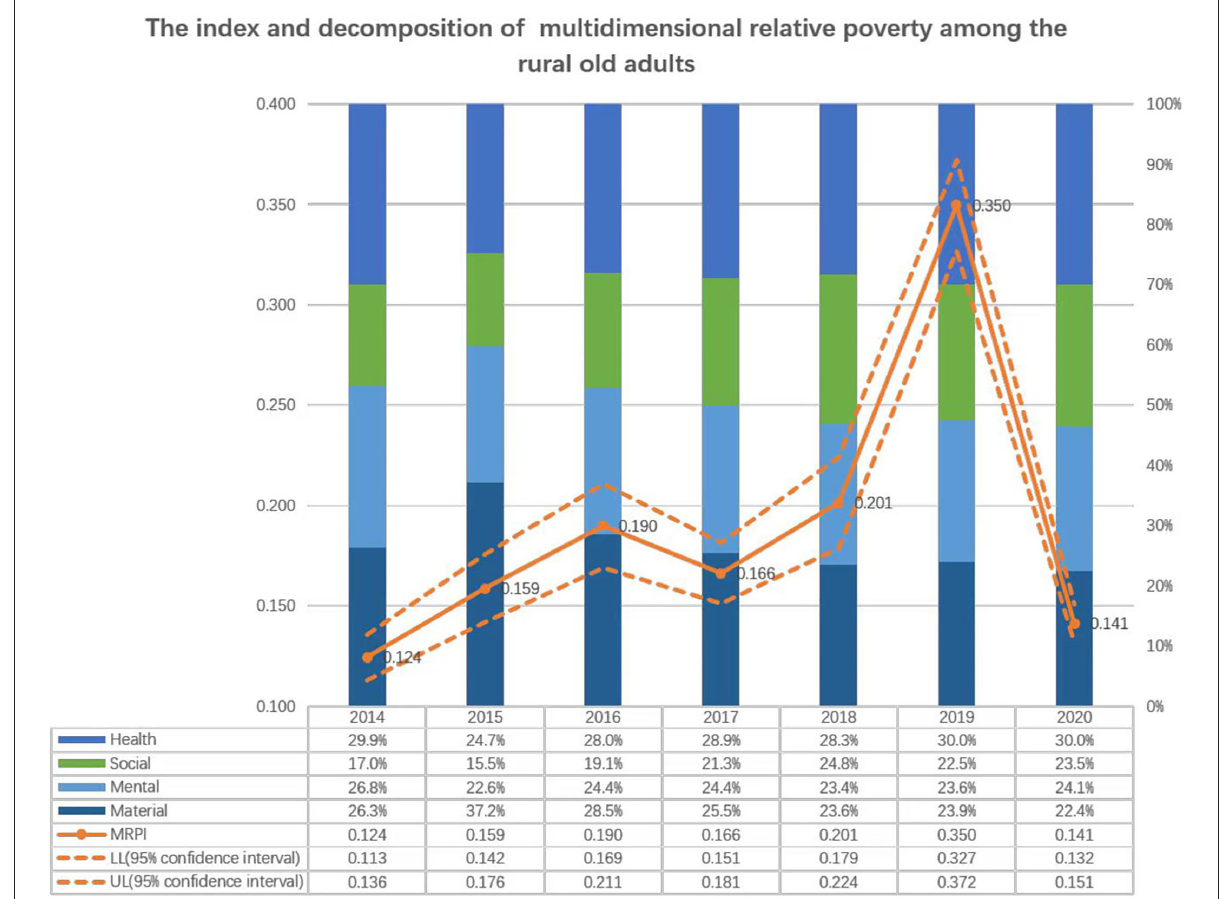
FIGURE1 The index and decomposition of multi-dimensional relative poverty among the rural old adults.